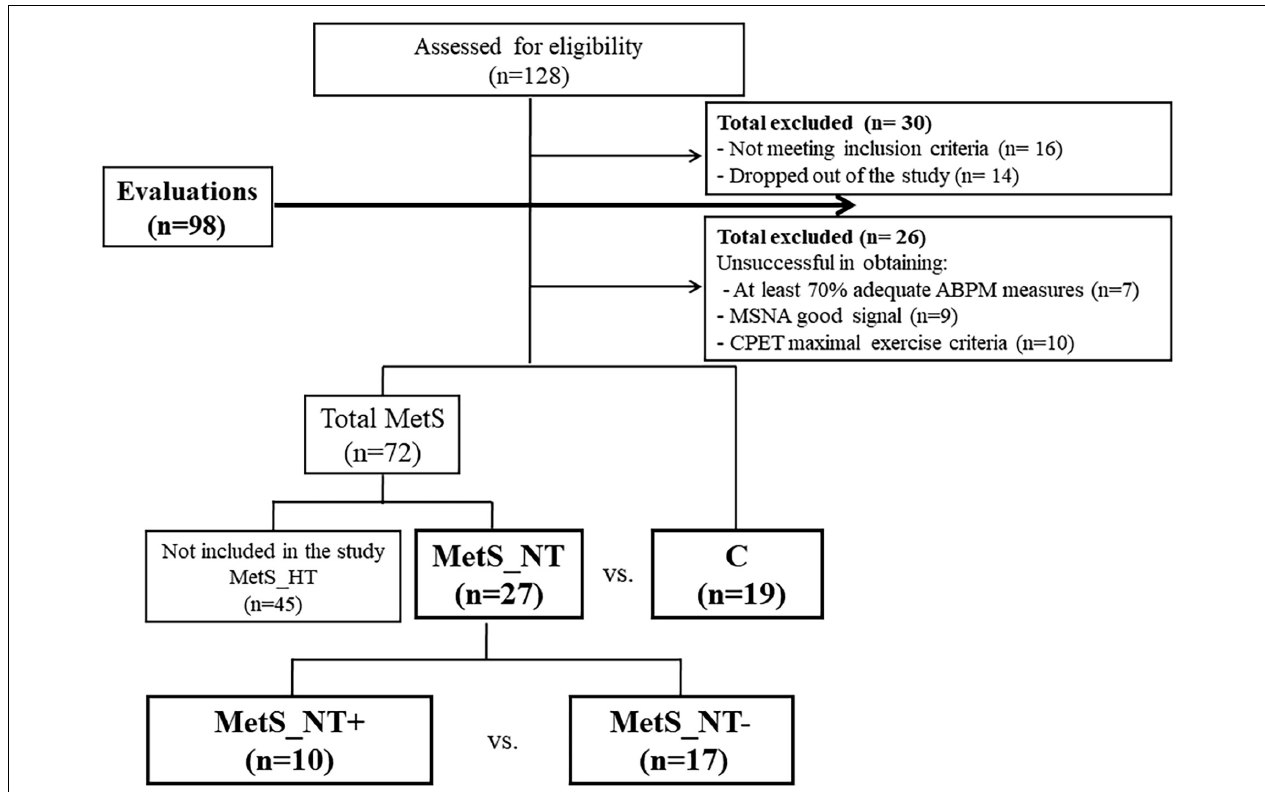
FIGURE 1 | Participants flowchart. Note that there are two different parts in the study. First, we compared normotensive MetS patients (MetS_NT) with the control (C) group. Then, we compared the subgroup of MetS_NT that presented exaggerated exercise BP (MetS_NT+) with those without exaggerated exercise blood pressure response (MetS_NT − ) during cardiopulmonary exercise test (CPET). ABPM, ambulatory blood pressure monitoring; MSNA, muscle sympathetic nerve